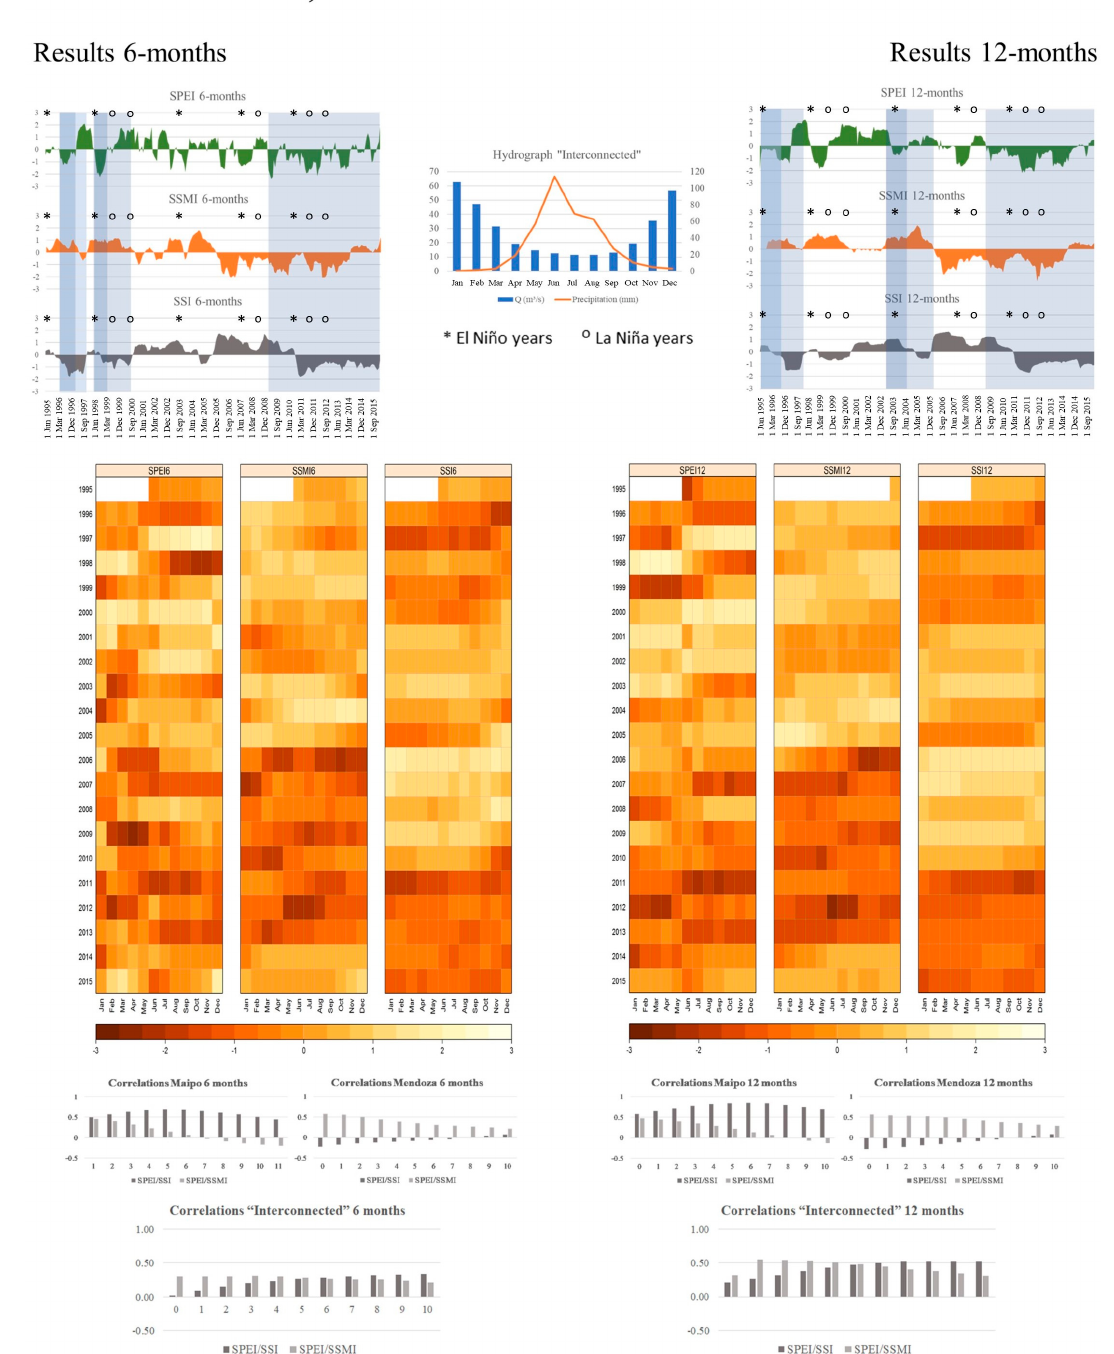
Figure 8. Graphical summary of results for the “Interconnected” river basin.